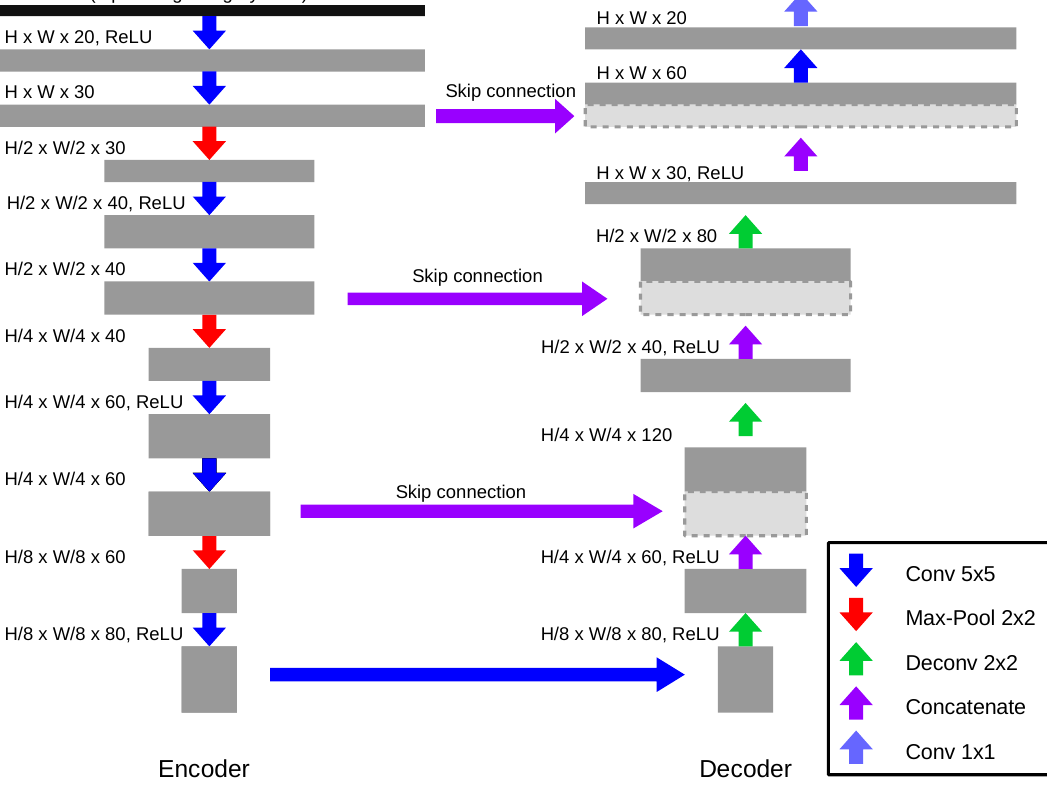
Figure 4. FCN network architecture used for the staff line detection and symbol detection. Both the type and the dimension of each layer is